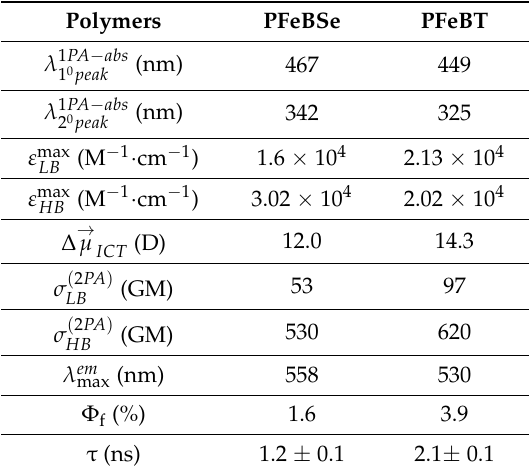
Table 1. Photophysical data of Chromophores 1–3 (in chloroform).